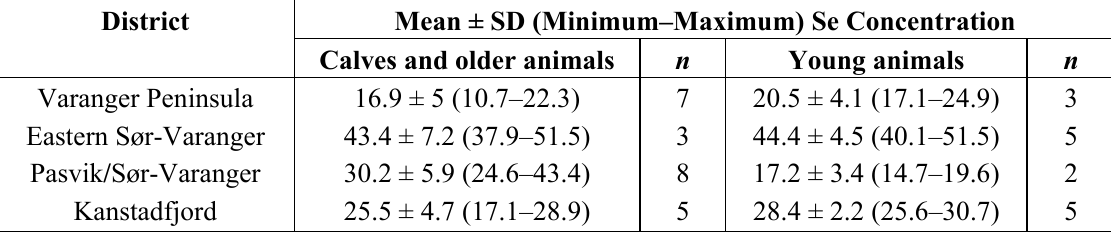
Table 4. Age stratified Se Concentration (µg/100 g ww) in reindeer meat from districts with mixed age